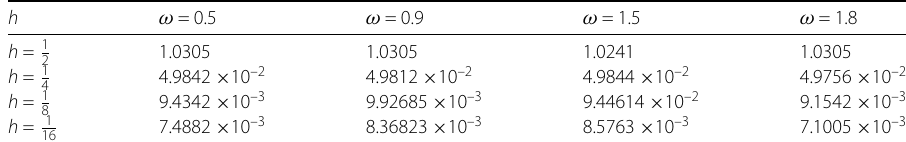
and γ = 0.1 for Example 2 20